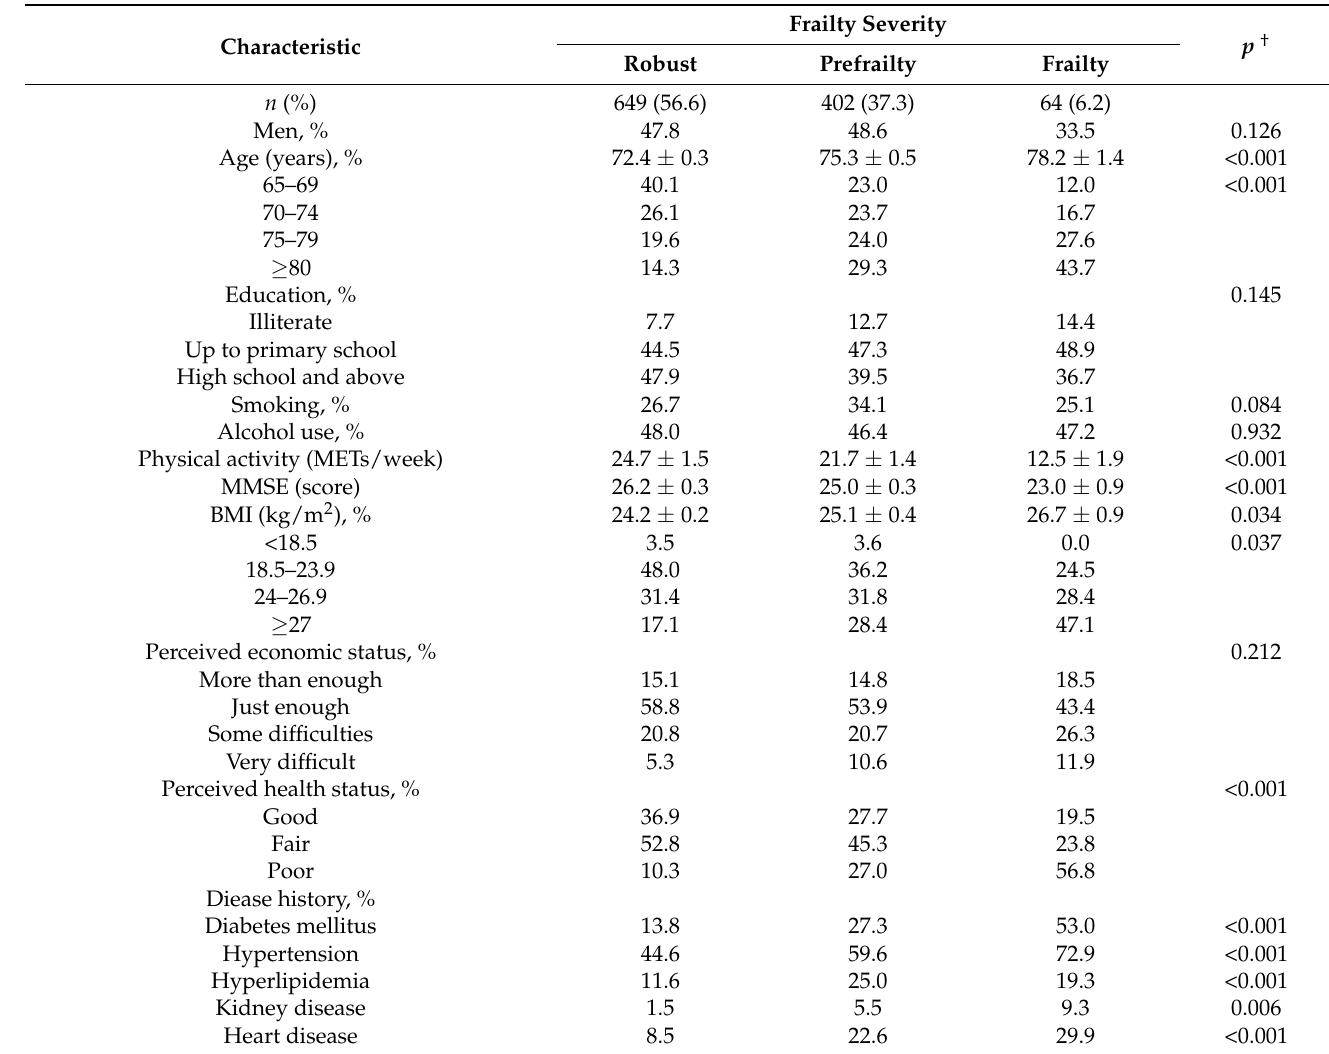
Table 1. Characteristics of older adults by frailty severity in the 2014–2016 Nutrition and Health Survey in Taiwan ( N = 1115)